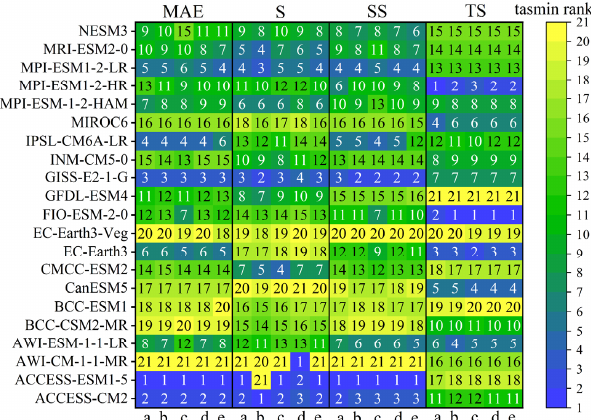
Figure 5. Fitting performance ranking of 21 climate models simulating the tasmin monthly series of the Yellow River Basin from 1995 to 2014 under different interpolation methods and evaluation metrics. a, b, c, d, and e under each evaluation method are the evaluation rankings of the five interpolation methods: BI, IDW, kriging, NNI, and spline, respectively. The higher the ranking, the higher the model’s fitting accuracy.